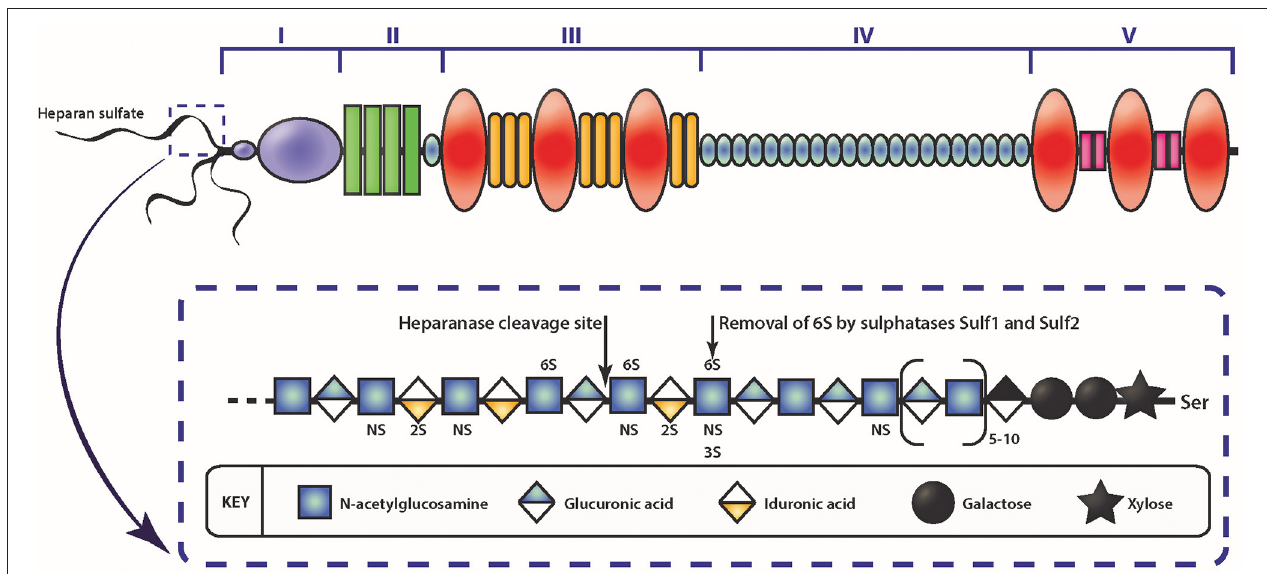
FIGURE 2 | Schematic diagram of the HSPG perlecan and HS. The different domains of perlecan are depicted by roman numerals. The insert depicts a schematic of HS represented by the repeating disaccharide of N-acetyl glucosamine and glucuronic acid (or iduronic acid) and sulfate moieties that can occur. Enzymatic modification of HS can occur via heparanase cleavage, resulting in smaller molecular weight fragments, or cleaving the 6-O sulfate on glucosamine via